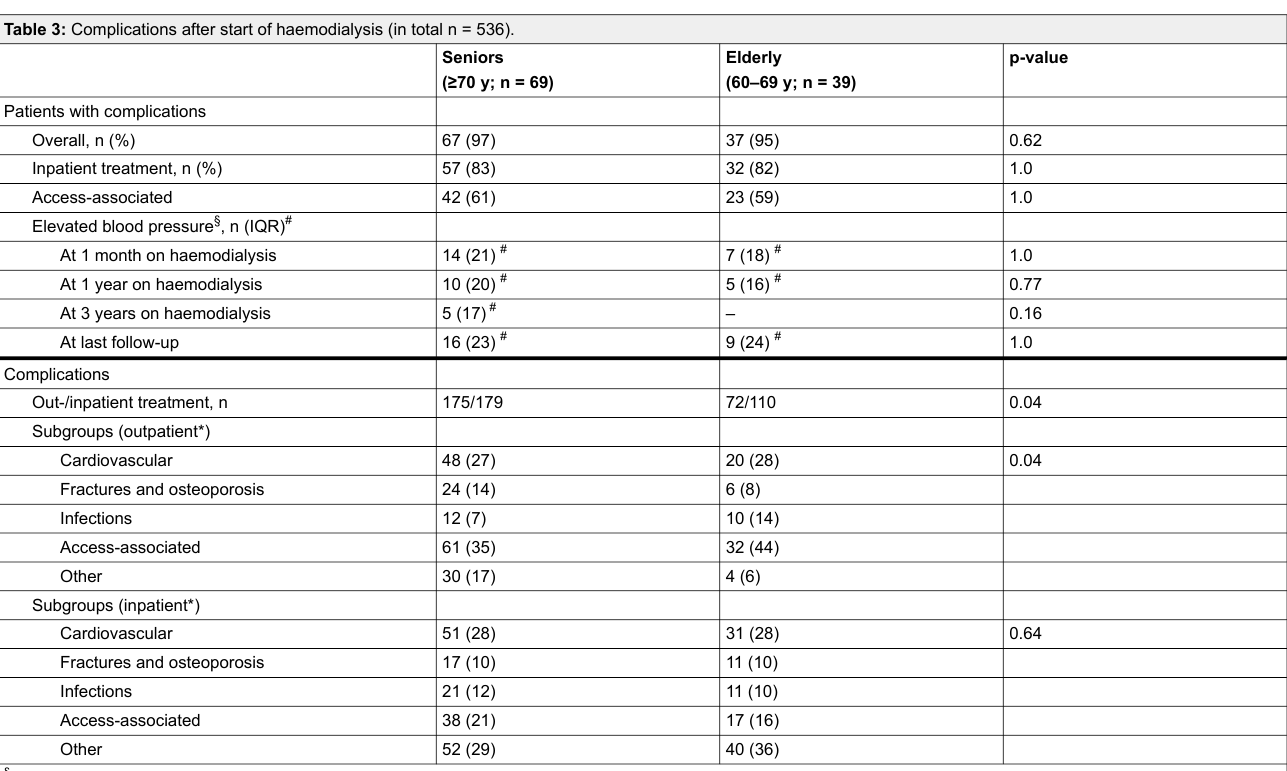
Table 3: Complications after start of haemodialysis (in total n =